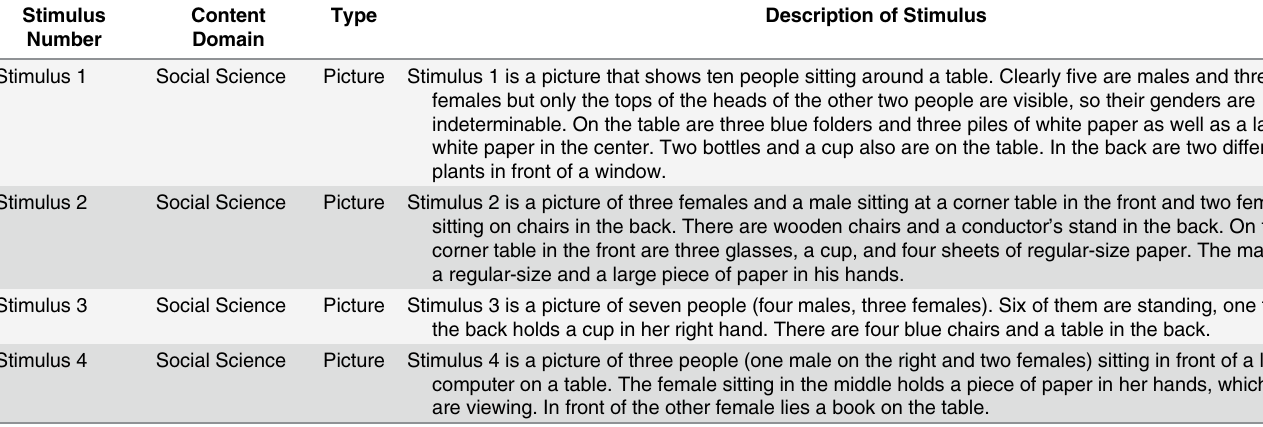
Table 1. Description of the stimuli used in Study